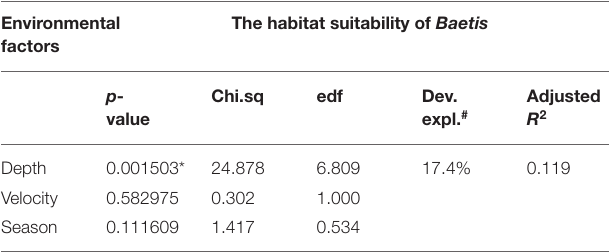
TABLE 1 | Generalized additive model results of the relationships between the habitat suitability of Baetis and environmental factors. Environmental